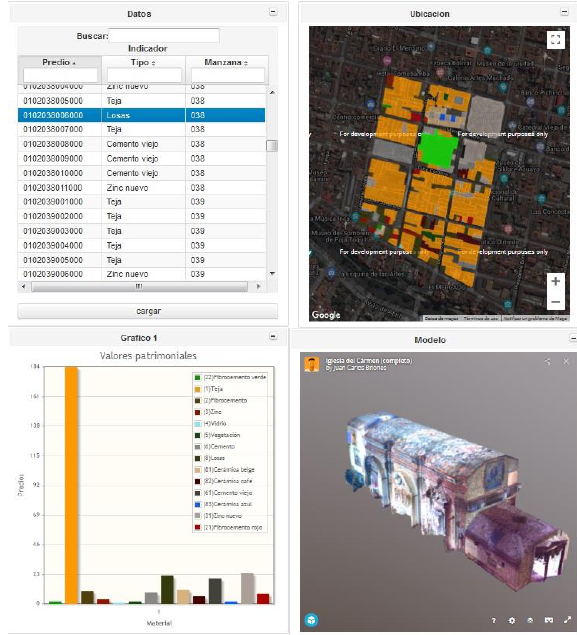
Figure 5. Multicriteria identification (proposed analysis): heights, areas of materiality, registration databases for the selected city building blocks, connected with the three- dimensional information gathered of the same selected